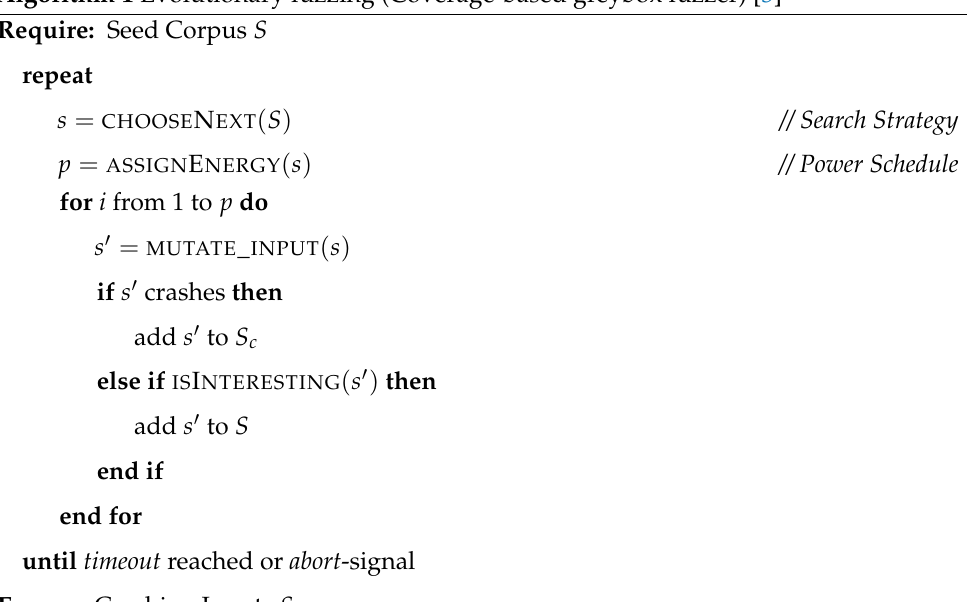
Algorithm 1 Evolutionary fuzzing (Coverage-based greybox fuzzer)